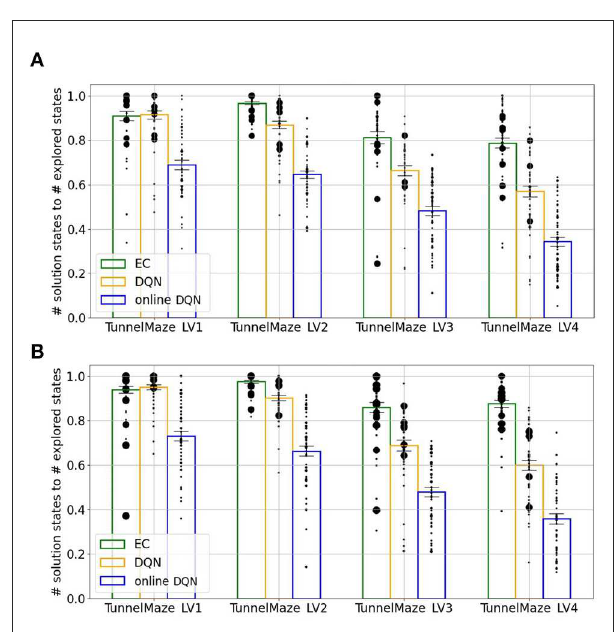
FIGURE10 Agents that learned faster propagated reward information more efficiently. The ratio between the number of the solution states, i.e., states from which the agent will navigate to the goal, and the number of explored states during training. Each bar represents an average over 50 simulations. The size of each black dot represents the frequency of that value. The vertical line on each bar represents the standard error of the mean. (A) After 250 learning trials. (B) After 500 learning trials. While more learning trials allowed replay (DQN) and online learning to propagate the reward information to a slightly larger fraction of visited nodes, the improvement was